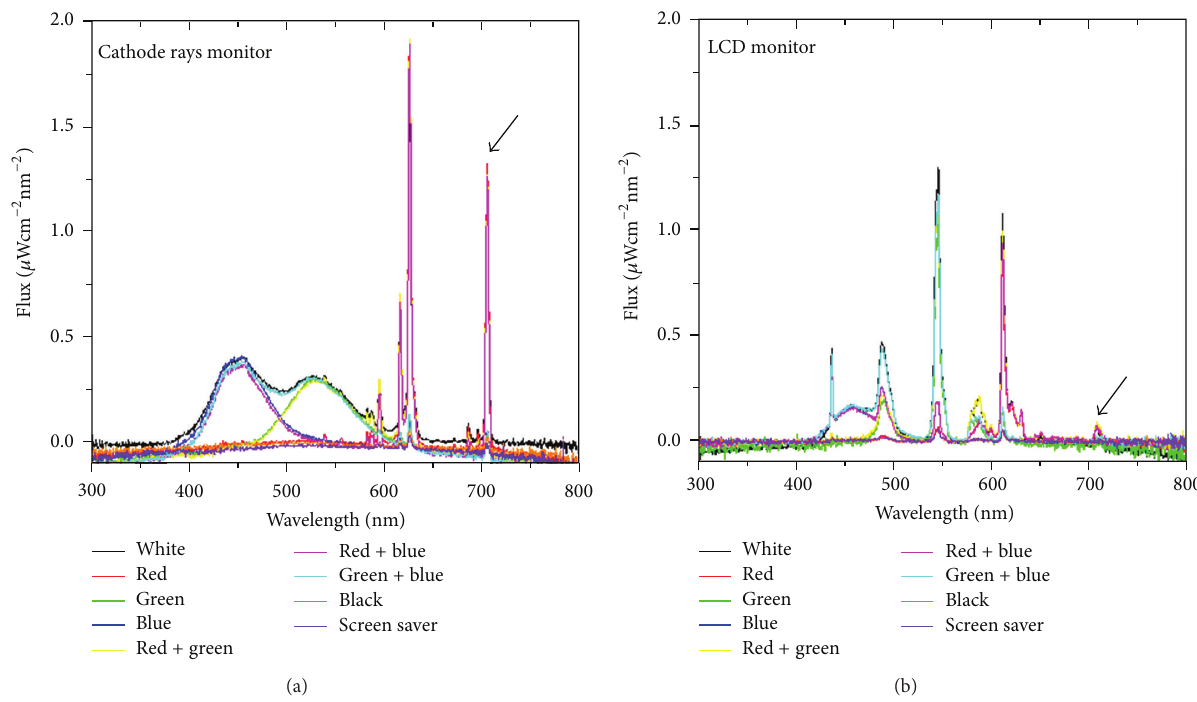
Figure 3: Light spectrum of two different computer monitors. (a) Hitachi CM615 cathode-ray tube (CRT) monitor. (b) ACER AL1916 liquid- crystal display (LCD) monitor. The arrows indicate the peaks at ∼